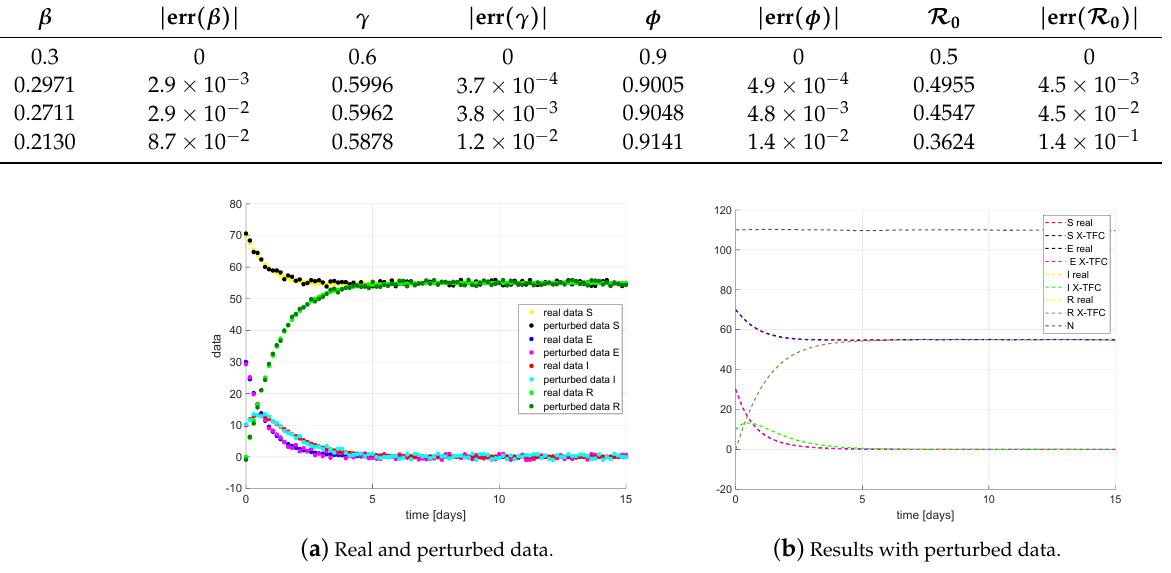
Figure 4. Results for SEIR model with δ = 3, n = 100, and L =